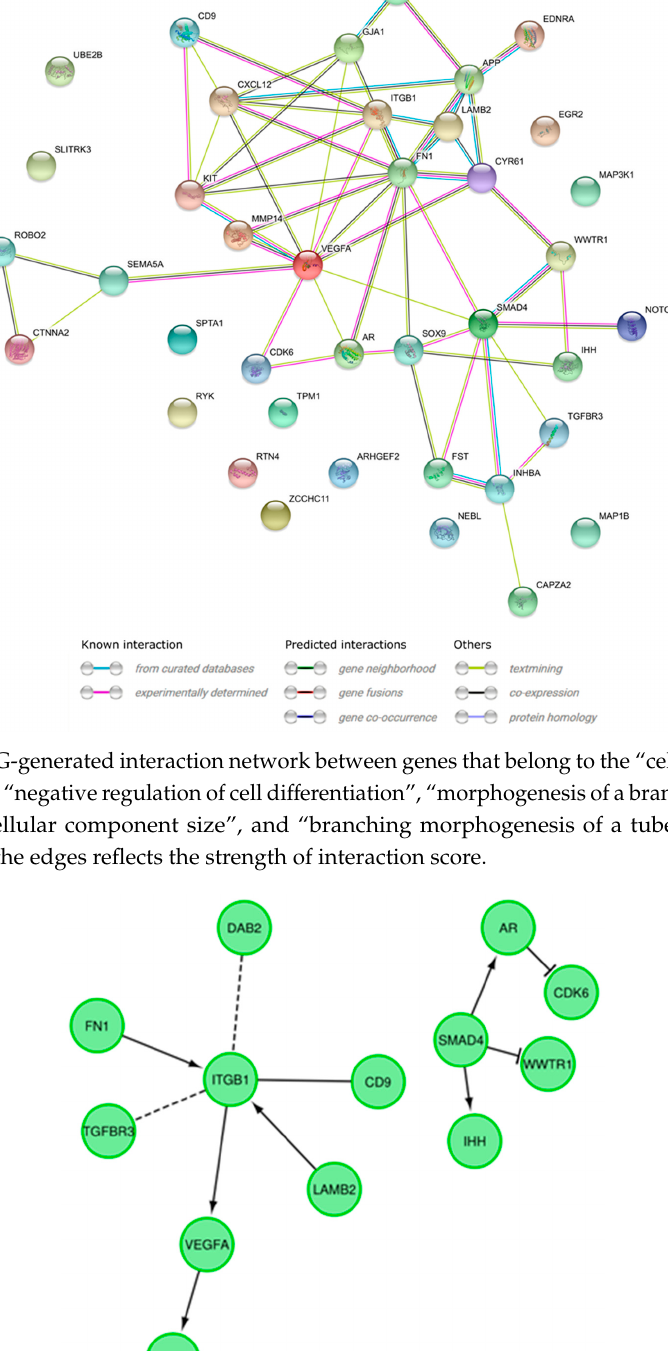
Figure 7. Heatmap showing the gene occurrence between differently expressed genes that belong to the “cellular component morphogenesis”, “negative regulation of cell differentiation”, “morphogenesis of a branching structure”, “regulation of cellular component size”, and “branching morphogenesis of a tube” GO BP terms. The yellow color is associated with gene occurrence in the GO Term. The intensity of the color corresponds to the amount of GO BP terms that each gene belongs to.